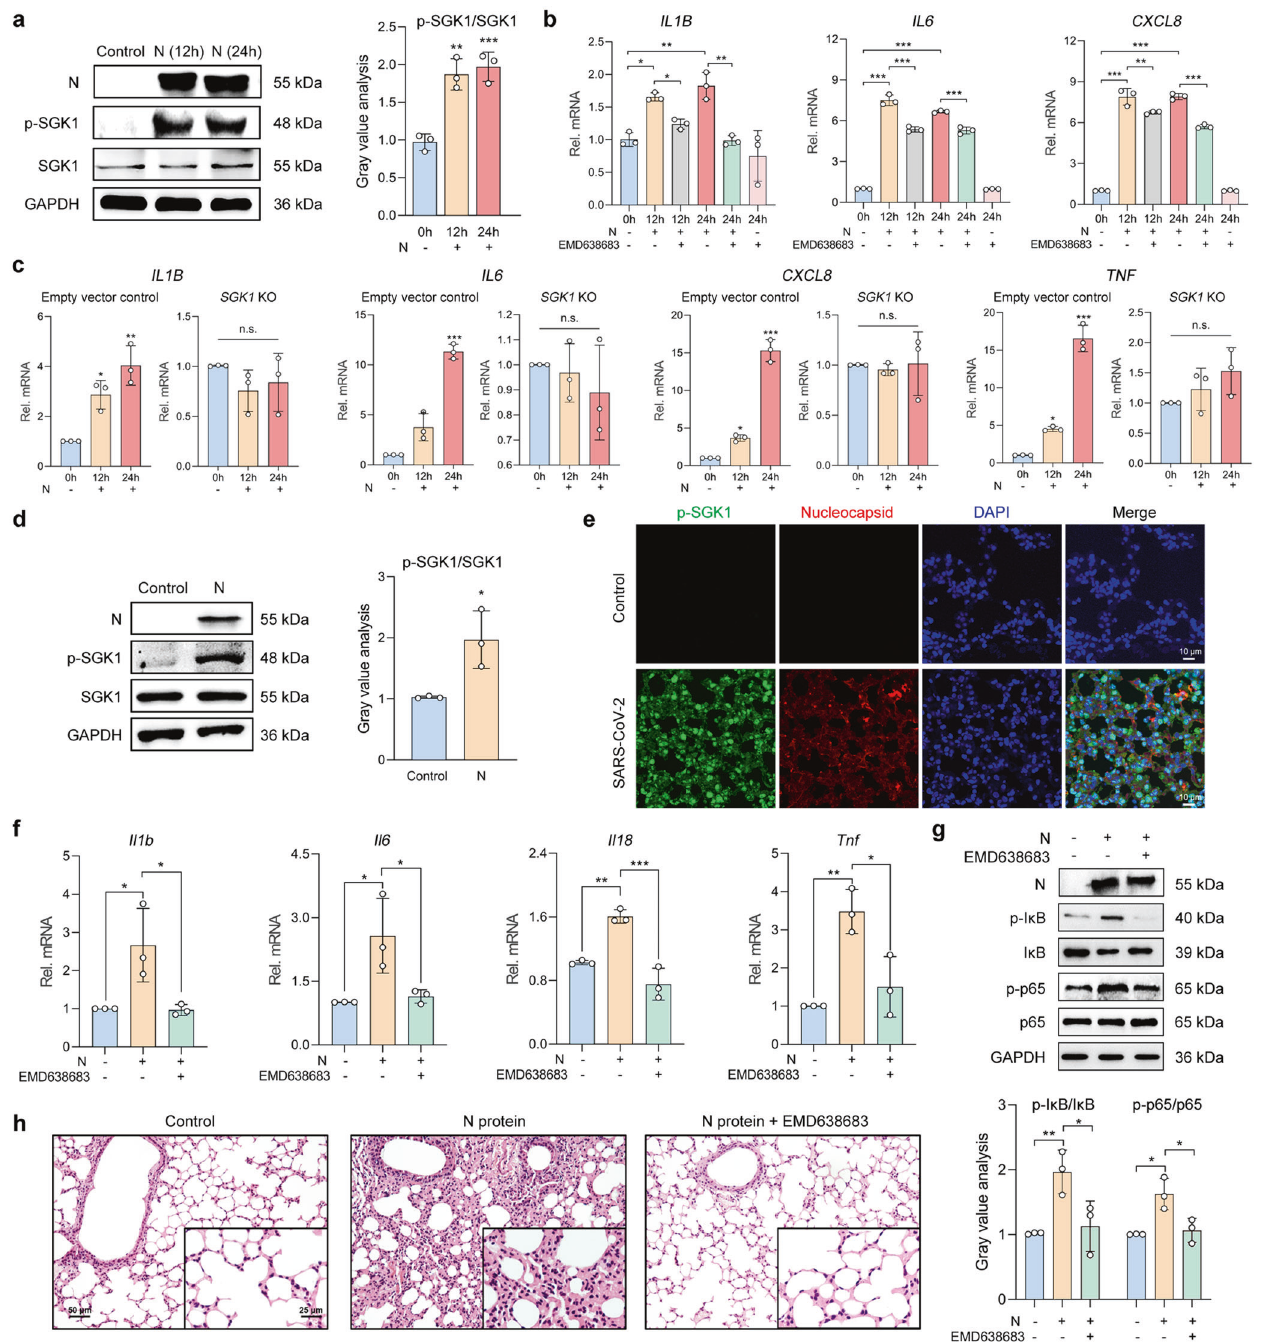
Fig. 4 SARS-CoV-2 N protein-triggered in fl ammation via the activation of SGK1 in RECs. a The phosphorylation level of SGK1 after N protein (50 μ g/ml) stimulation in BEAS-2B cells, with the gray value analysis ( n = 3). b The effect of EMD638683 (50 μ M) on the mRNA expressions of pro-in fl ammatory cytokines in N protein (50 μ g/ml)-stimulated BEAS-2B cells ( n = 3). c The mRNA expressions of cytokines after N protein (50 μ g/ml) stimulation in the empty vector control or SGK1 KO BEAS-2B cells ( n = 3). d The phosphorylation level of SGK1 in lungs of N protein (0.25 mg/kg)-stimulated mice, with the gray value analysis ( n = 3). e Fluorescence labeling of phosphorylated SGK1 (green) and N protein (red) in lung slices of hACE2-transduced mice infected with SARS-CoV-2 (1 × 10 5 PFU). Scale bars, 10 μ m. f The effect of EMD638683 (10 mg/kg) on the mRNA expressions of cytokines in N protein (0.25 mg/kg)-stimulated mice ( n = 3). g The effect of EMD638683 (10 mg/kg) on the phosphorylation level of I κ B and NF- κ B p65 subunit in N protein (0.25 mg/kg)-stimulated mice, with the gray value analysis ( n = 3). h H&E staining of lung slices from N protein (0.25 mg/kg)-stimulated mice with or without treatment with EMD638683 (10 mg/kg). Scale bars, 50 μ m and 25 μ m. Data were shown as mean ± SD, * P < 0.05, ** P < 0.01, *** P < 0.001 compared with the control group or indicated by lines, n.s. P >